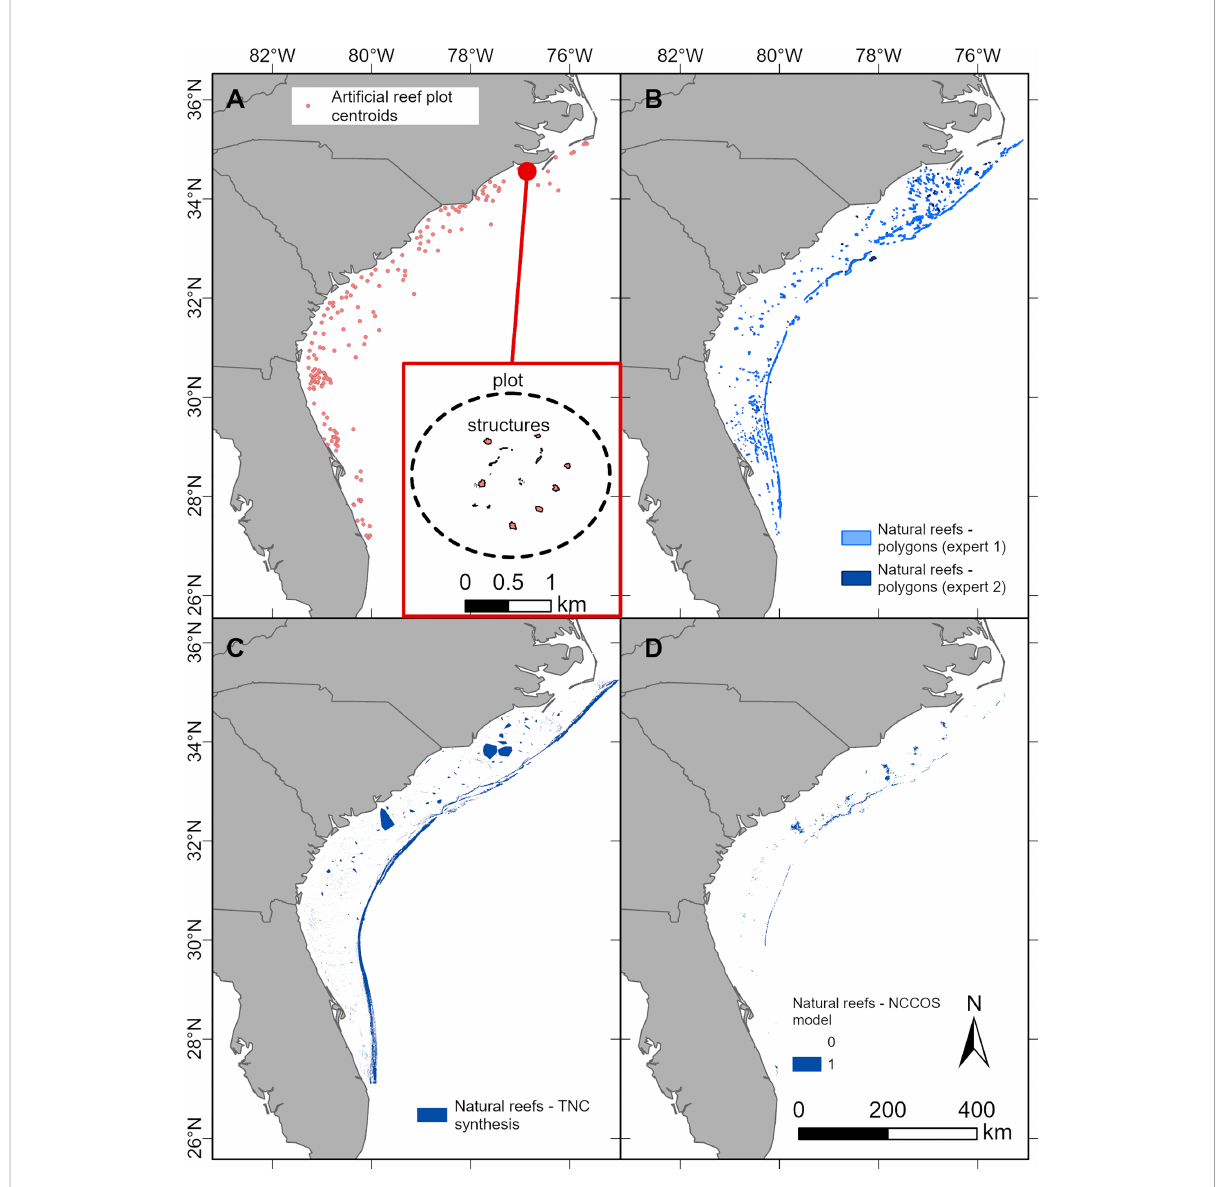
FIGURE 2 Locations of arti fi cial reefs (A) and natural reefs (B – D) along the southeastern US continental shelf. (A) Arti fi cial reef locations correspond to centroids of permitted arti fi cial reef plots, and the size of the arti fi cial reef dots corresponding to each plot is not to scale. The inset in panel A depicts one NC arti fi cial reef permitted plot (dashed line) and the arti fi cial reef structures (red polygons) within. (B) Natural reefs delineated by expert-drawn polygons. (C) Natural reefs predicted by the TNC synthesis. (D) Natural reefs predicted by the NCCOS model (likelihood